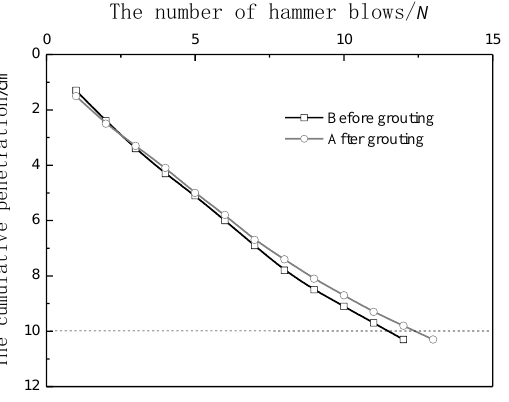
Figure 12. Comparison of dynamic penetration test of No. 3 pile before and after grouting.